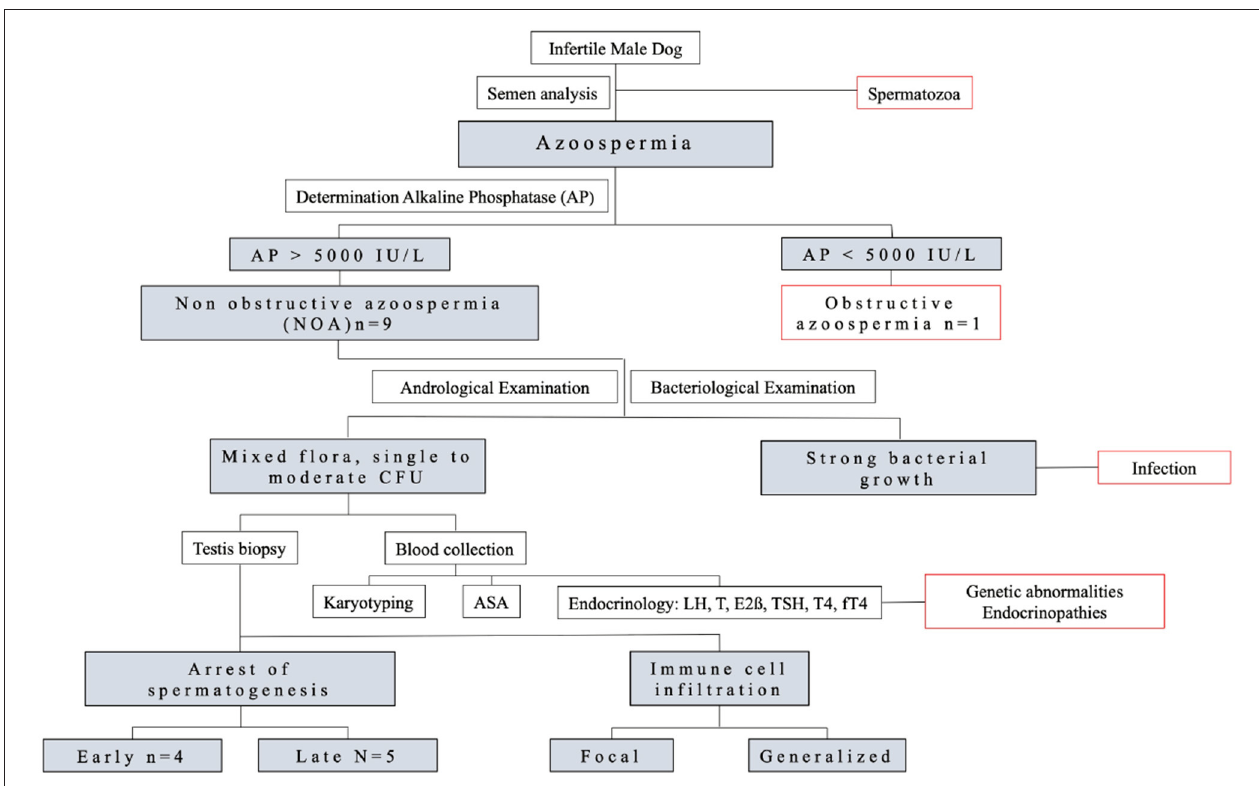
FIGURE 1 | Flowchart of the experimental